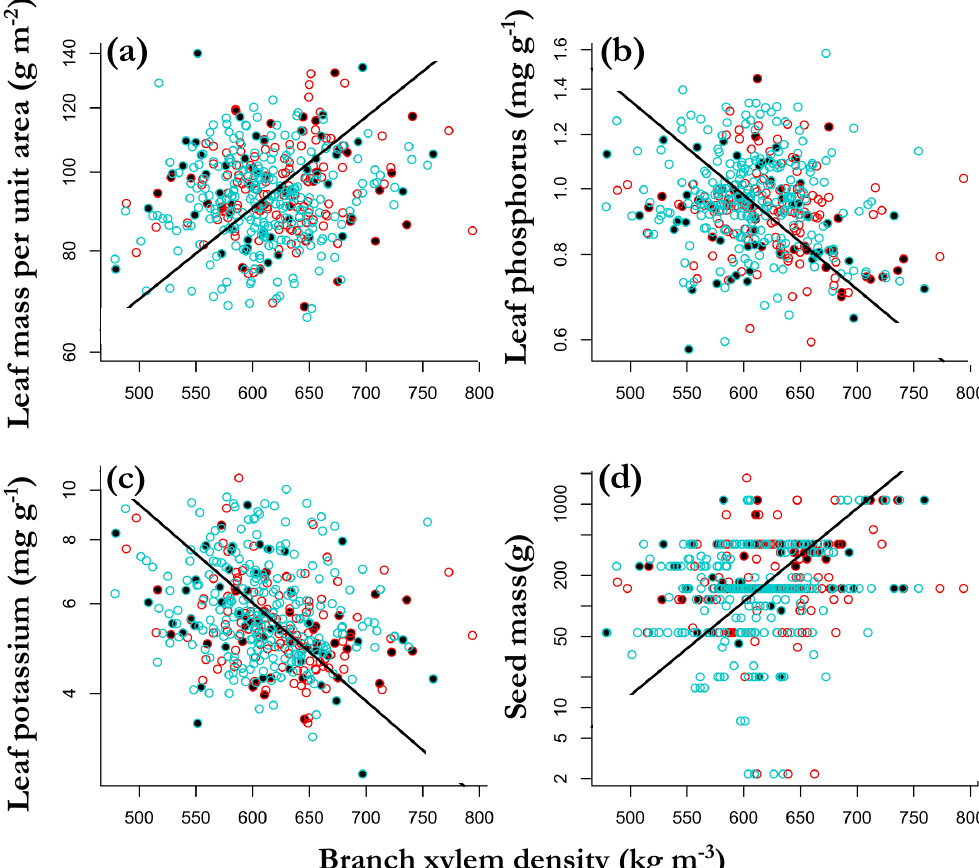
Fig. 4. Standard Major Axis (SMA) regression lines between the derived species components of branch xylem density ( ρ x ) and those for mass per unit area ( M A ), foliar [P] and foliar [K] for the same species and the average seed mass (S) for the associated genus. Red open circles indicate species found on low fertility sites and the blue open circles indicate species found on high fertility sites. Species found on both soil fertility groups are indicated with closed circles (see text for details). The black solid lines show the SMA model fit which did not depend on soil fertility.